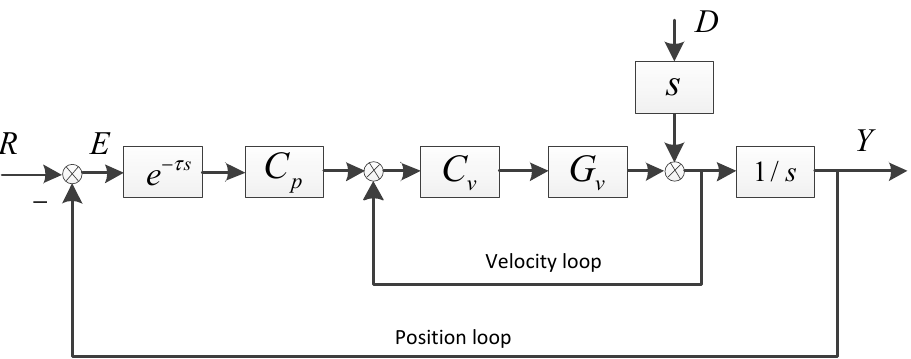
C and C C and C v p v p